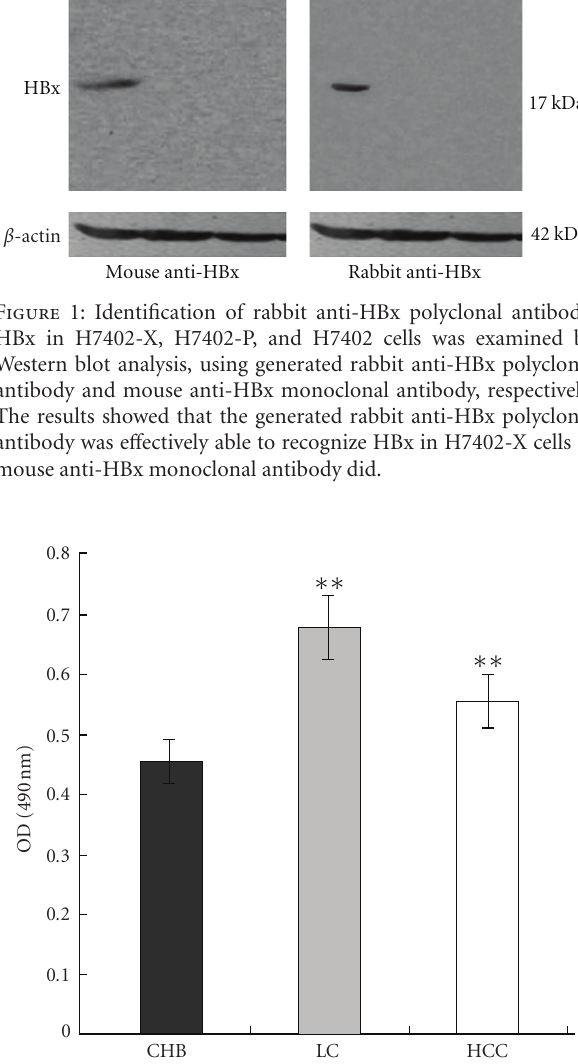
Figure 2: ELISA showed the quantities of anti-HBx (IgG) in sera from clinical CHB patients, LC patients, HCC patients. The value in each group was mean OD ( ∗∗ P < . 01, versus CHB, Tukey